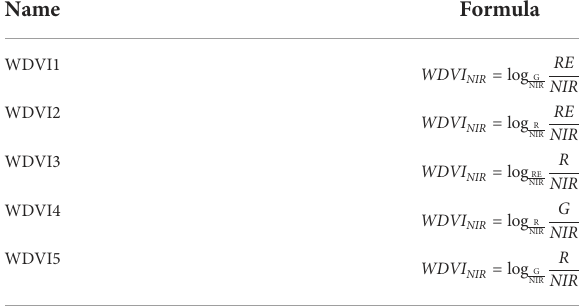
TABLE 2 Five medium Combination Vegetation